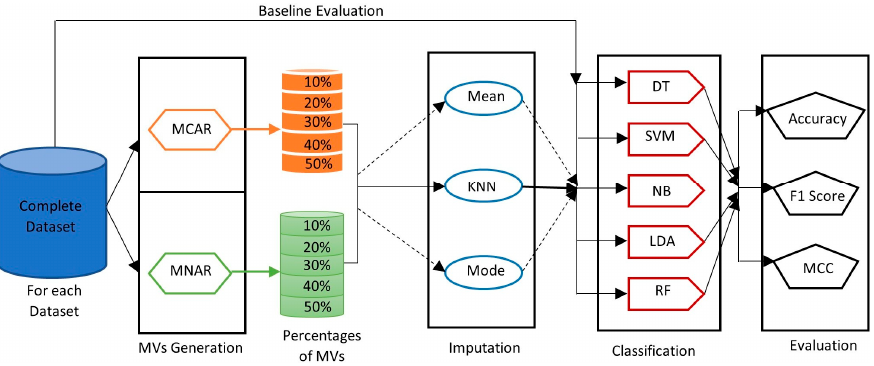
Figure 1. The framework of the three groups of experiments A, B, and C.